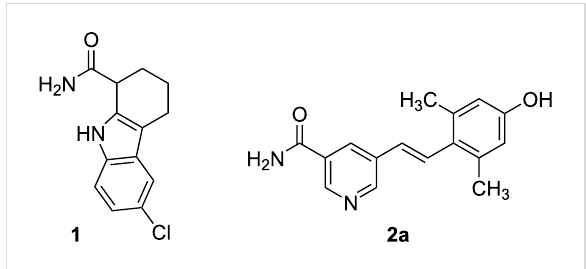
Figure 1: Selisistat ( 1 ) and hit compound GW435821X ( 2a